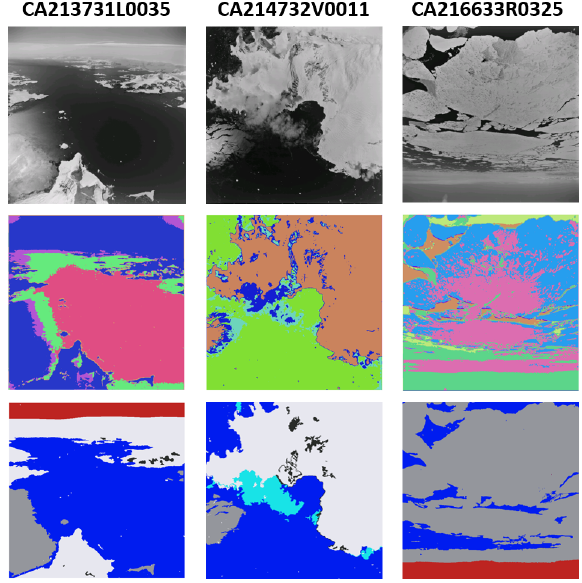
Figure 3. Examples of self-labelled images with raw images at the top, the unsupervised segmentation in the middle (colours are assigned randomly) and the final ground truth at the